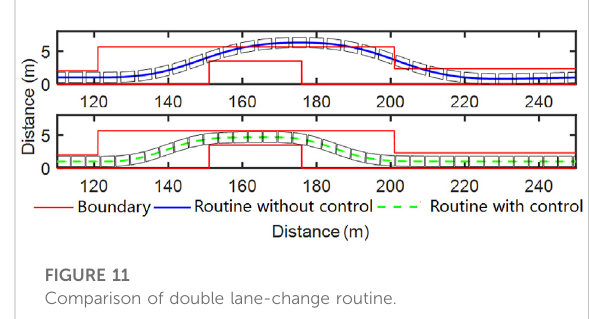
FIGURE 11 Comparison of double lane-change routine.